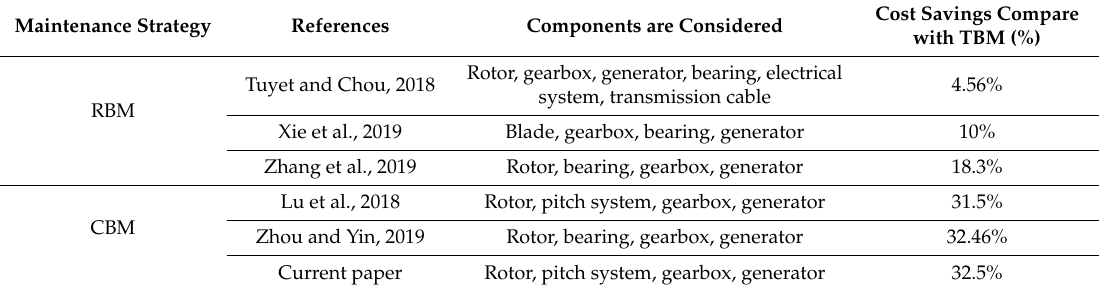
Table 10. Comparison of maintenance costs. RBM: reliability-based maintenance.